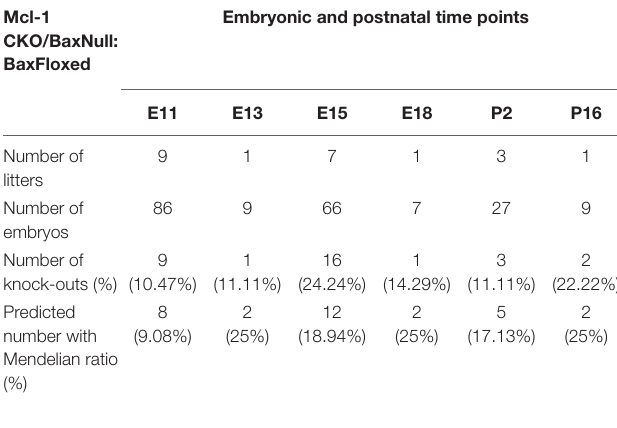
TABLE 2 | Survival of Mcl-1 CKO/BaxNull/BaxFloxed embryos. Mcl-1